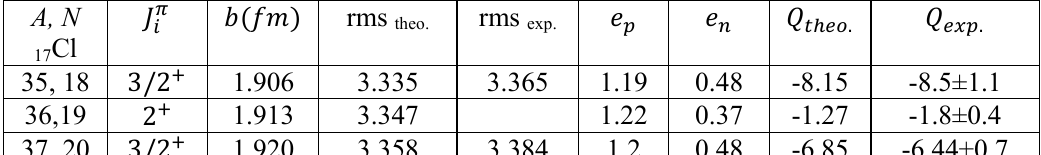
Table 5: Quadrupole moments in units of (cid:2187) (cid:2188)(cid:2195) (cid:2779) calculated with harmonic oscillator (HO) potential for Chlorine (Cl) isotopes (Z = 17). Effective proton and neutron charges are deduced from the core polarization calculation. Experimental quadrupole moments are taken from Ref. [18].